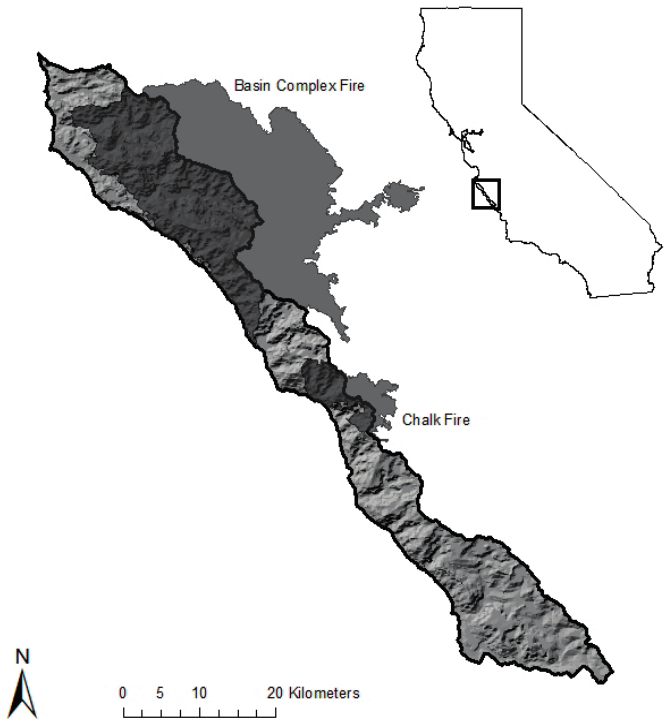
Figure 1. The Big Sur region of the central California coast and the 2008 Basin Complex and Chalk